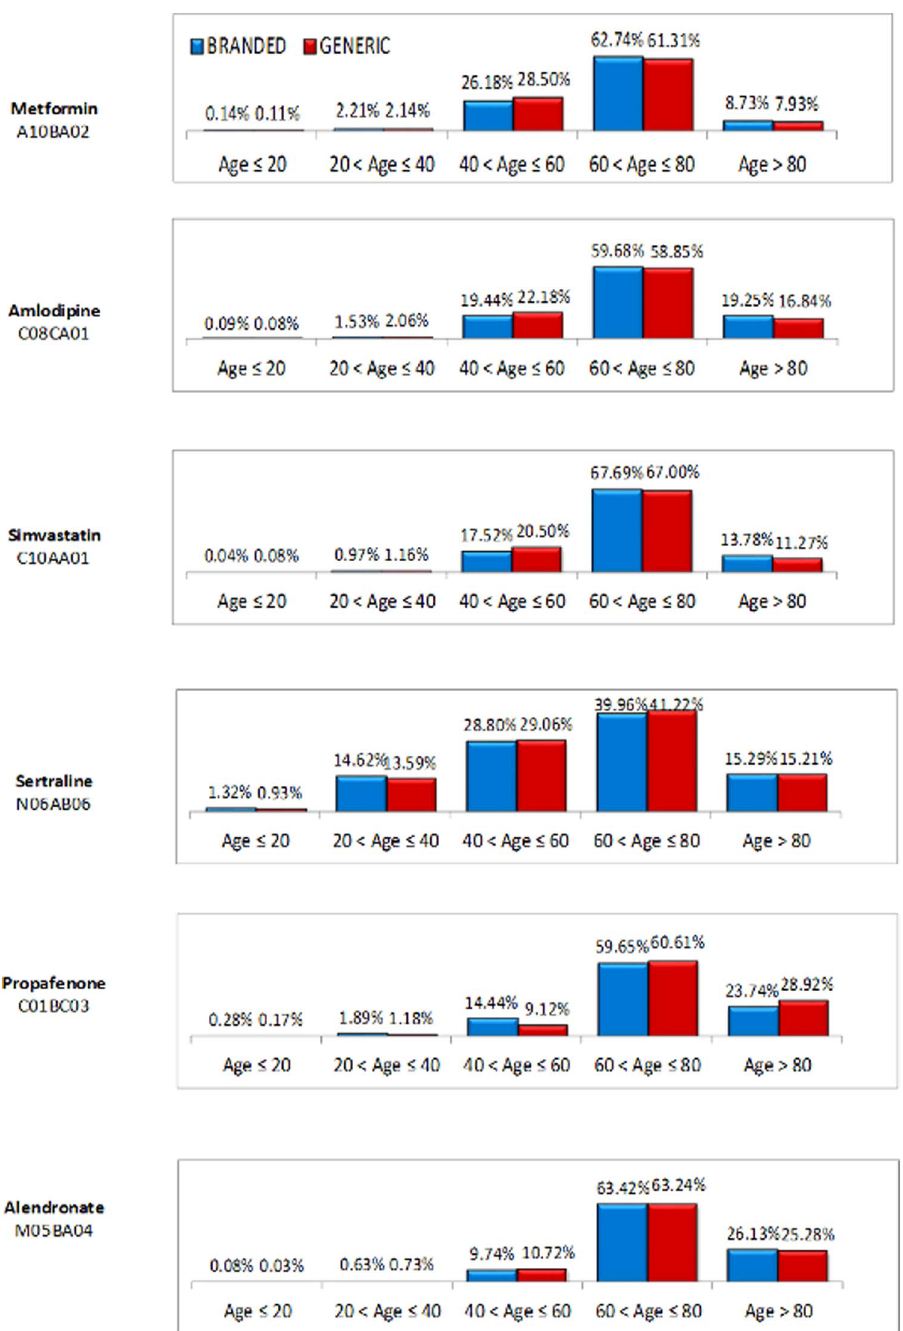
Figure 1. Distribution of the sample per age group and studied drug.